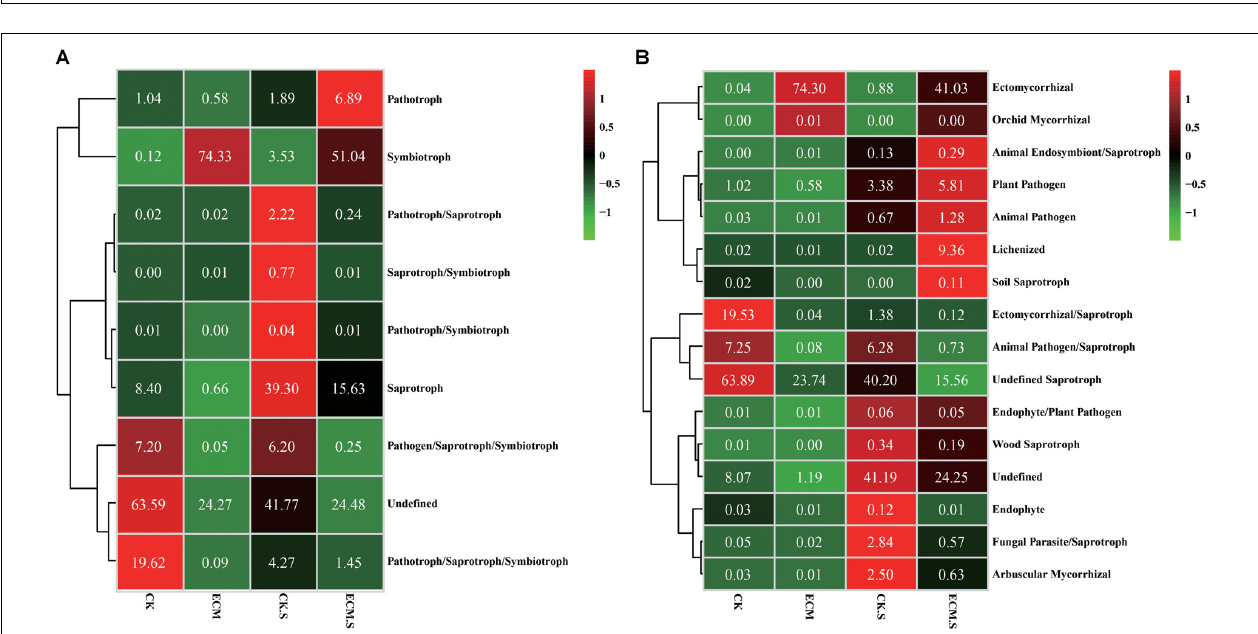
FIGURE 6 | The relative abundance of putative metabolic functions of the bacterial community in Q. aliena roots and the surrounding soil predicted using PICRUSt software based on the COG (A) , and KEGG (B) database. ECM, ectomycorrhizae; ECM.S, ectomycorrhizosphere soil; CK, roots of Q. aliena without T. indicum partner; CK.S, rhizosphere soil of Q. aliena without T. indicum partner. Data of the above metabolic function analysis are presented as mean ± SD (error bars), calculated from the four biological replicates of each treatment group.